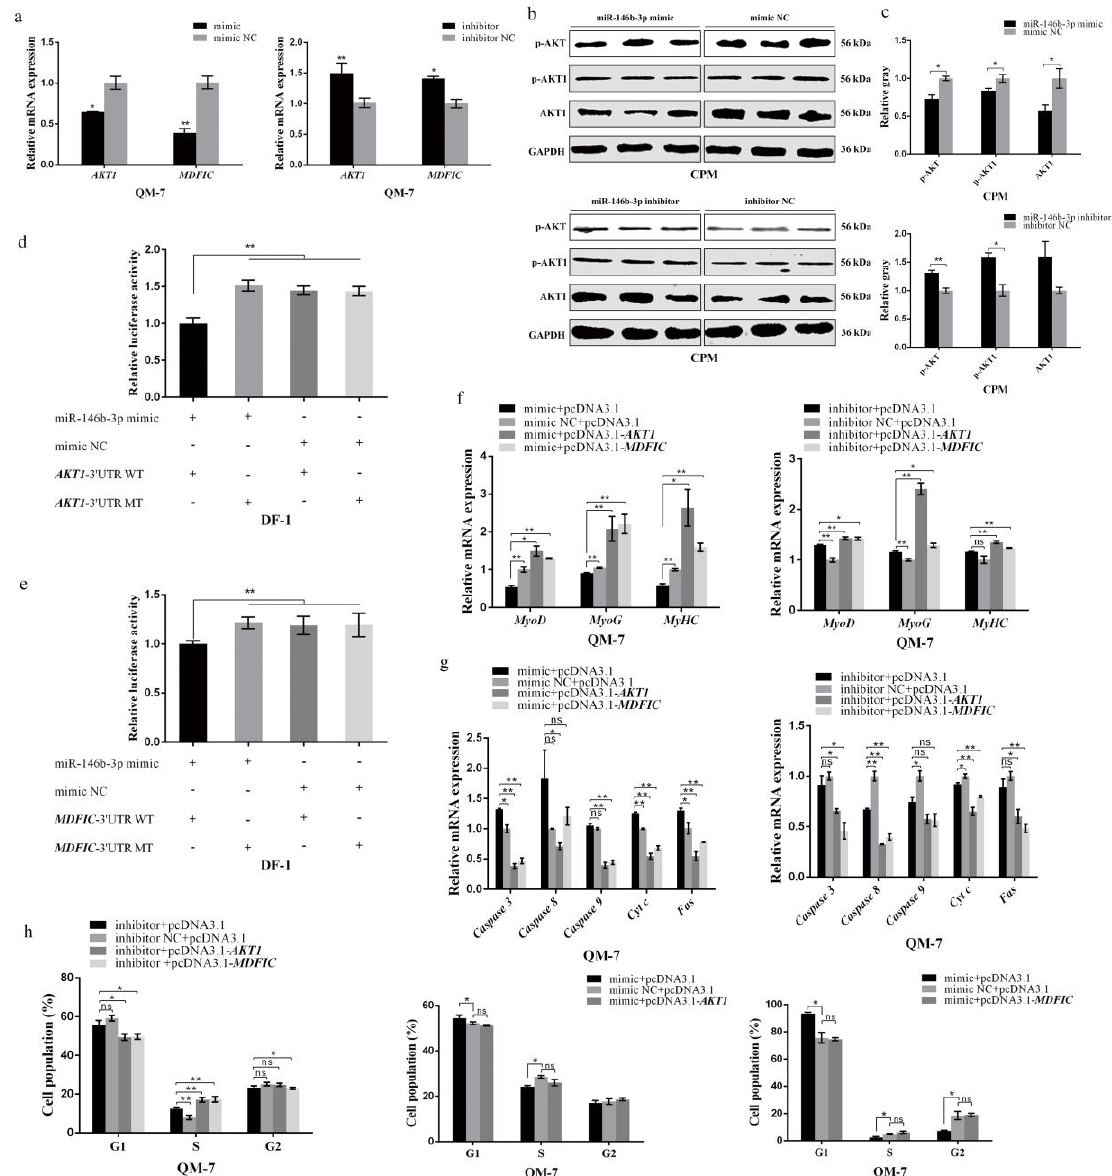
Figure 4. miR-146b-3p targets AKT1 and MDFIC and downregulates PI3K/AKT pathway activity. ( a ) Relative mRNA expression of AKT1 and MDFIC in QM-7 cells after overexpression or inhibition of miR-146b-3p. ( b ) The phosphorylation levels of AKT and AKT1 and the protein expression of AKT1 after transfecting miR-146b-3p mimic or inhibitor in CPMs. ( c ) Gray value analysis of protein bands in (b). ( d ) Dual-luciferase report assay performed after co-transfecting the wild type or mutant 3′UTR of AKT1 with miR-146b-3p mimic or mimic NC in DF-1 cells. ( e ) Dual-luciferase report assay performed after co-transfecting the wild type or mutant 3′UTR of MDFIC with miR-146b-3p mimic or mimic NC in DF-1 cells. ( f ) Relative mRNA expression of the cell differentiation-related genes after co-transfection. ( g ) Relative mRNA expression of the cell apoptosis-related genes after co-transfection. ( h ) Cell cycle analysis of QM-7 cells after co-transfection. Results of all groups are shown as mean ± S.E.M. of three independent assessment methods. Statistical significance of the mean di ff erence was assessed using unpaired two-sample t -tests. * p < 0.05; ** p < 0.01. NC, negative